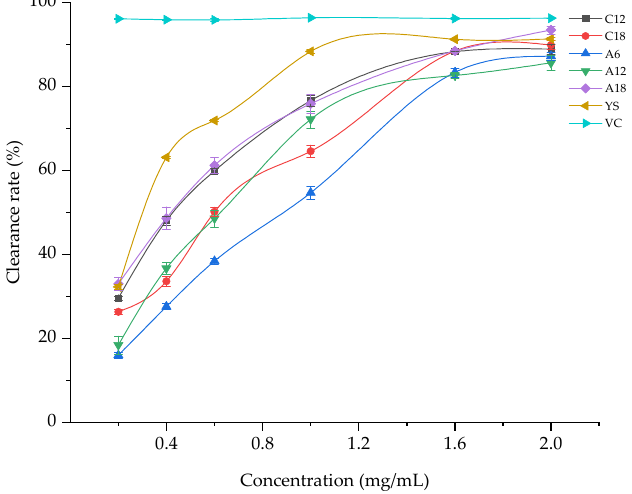
Figure 2. DPPH free radical clearance rate variation with extract concentration (C12 and C18 represented agarwood produced by A. crassna after 12 and 18 months of inoculation, respectively; A6–A18 represented agarwood produced by A. sinensis after 6, 12, and 18 months of inoculation, respectively; YS and VC represented wild agarwood and ascorbic acid, respectively).